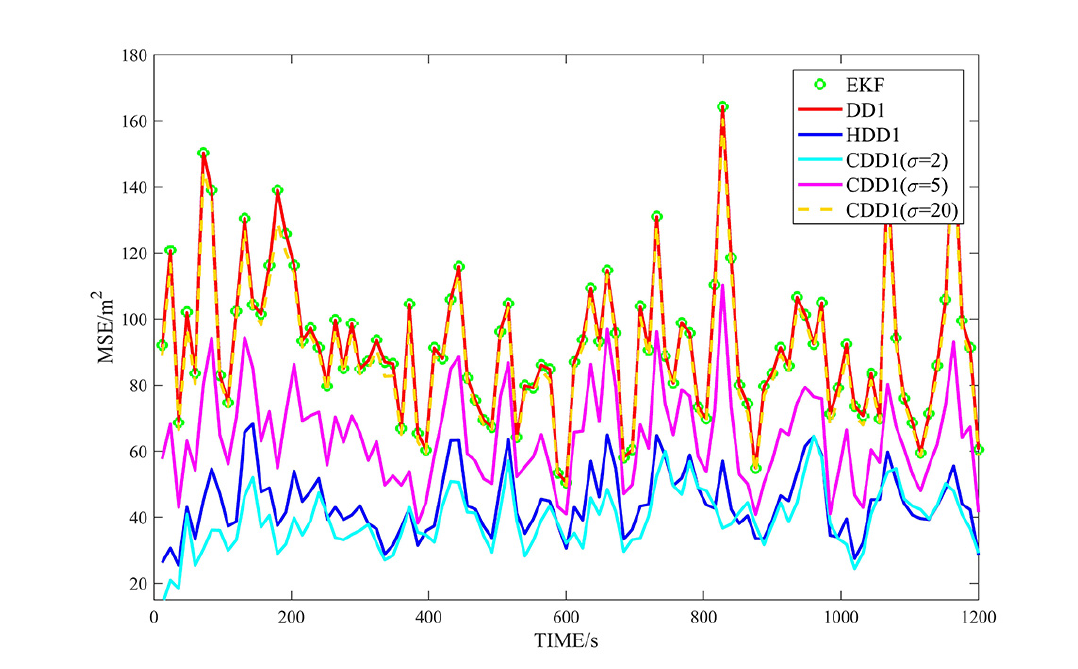
Figure 2. MSEs of ϕ with first-order approximate filters in non-Gaussian noises.